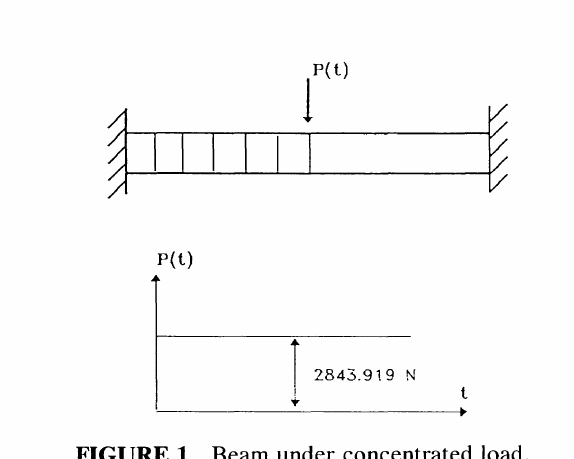
FIGURE 1 Beam under concentrated